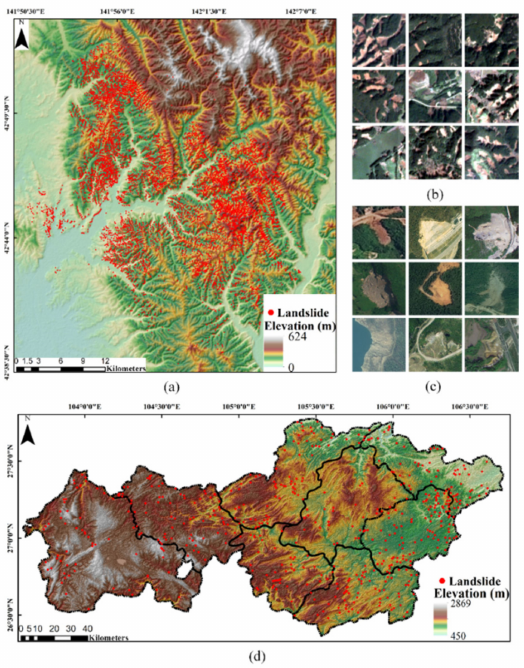
Figure 1. The geographical distribution of landslide datasets. ( a ) is the landslide distribution and topography in the Iburi district. ( b ) is the detailed landslide shapes in the Iburi dataset, the majority of landslides are continuous small- and medium-sized shallow detrital slides. ( c ) is the detailed landslide shapes in the Bijie dataset. An image contains a landslide. The size of both datasets is 224 × 224 pixels, and the resolutions are 3 m and 0.8 m respectively. ( d ) is the landslide distribution and topography in Bijie